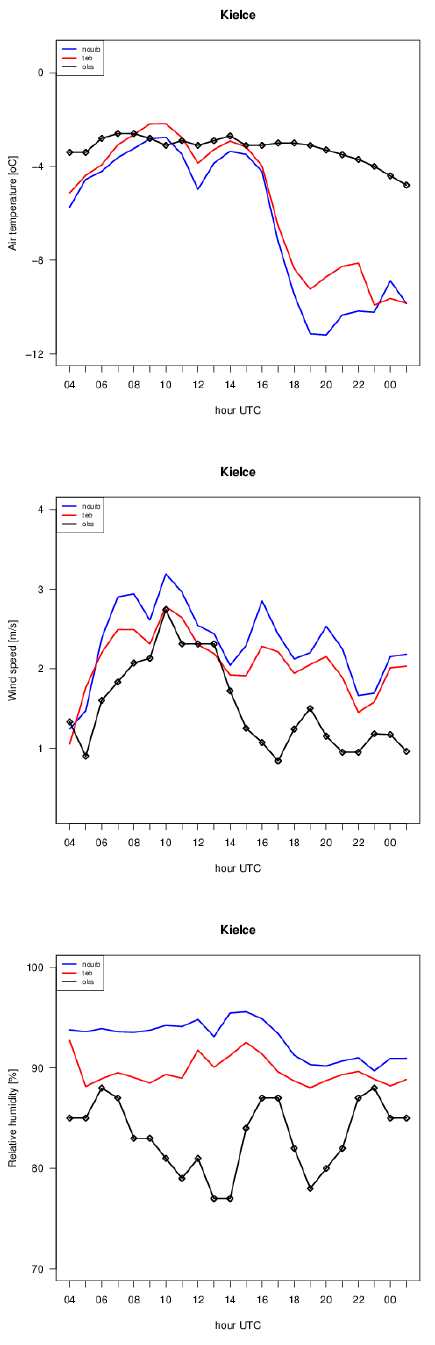
Fig. 9. Comparison of modelled meteorological parameters with ob- Figure 9 Comparison of modelled meteorological parameters with observations from servations from Kielce station for 3 January 2011 (red line - urban Kielce station for 3 rd of January 2011 (red line – urban scenario, blue line = non-urban scenario, blue line - non-urban scenario, black line - observations). scenario, black - observations) wind speed was reproduced correctly at most stations (aver- age MBE = 0.65 m s − 1 for urban scenario). At some stations (Warsaw-Krucza, Warsaw-Targowek, Opole) the model sys- tematically underestimated wind speed by about 1–2 m s − 1